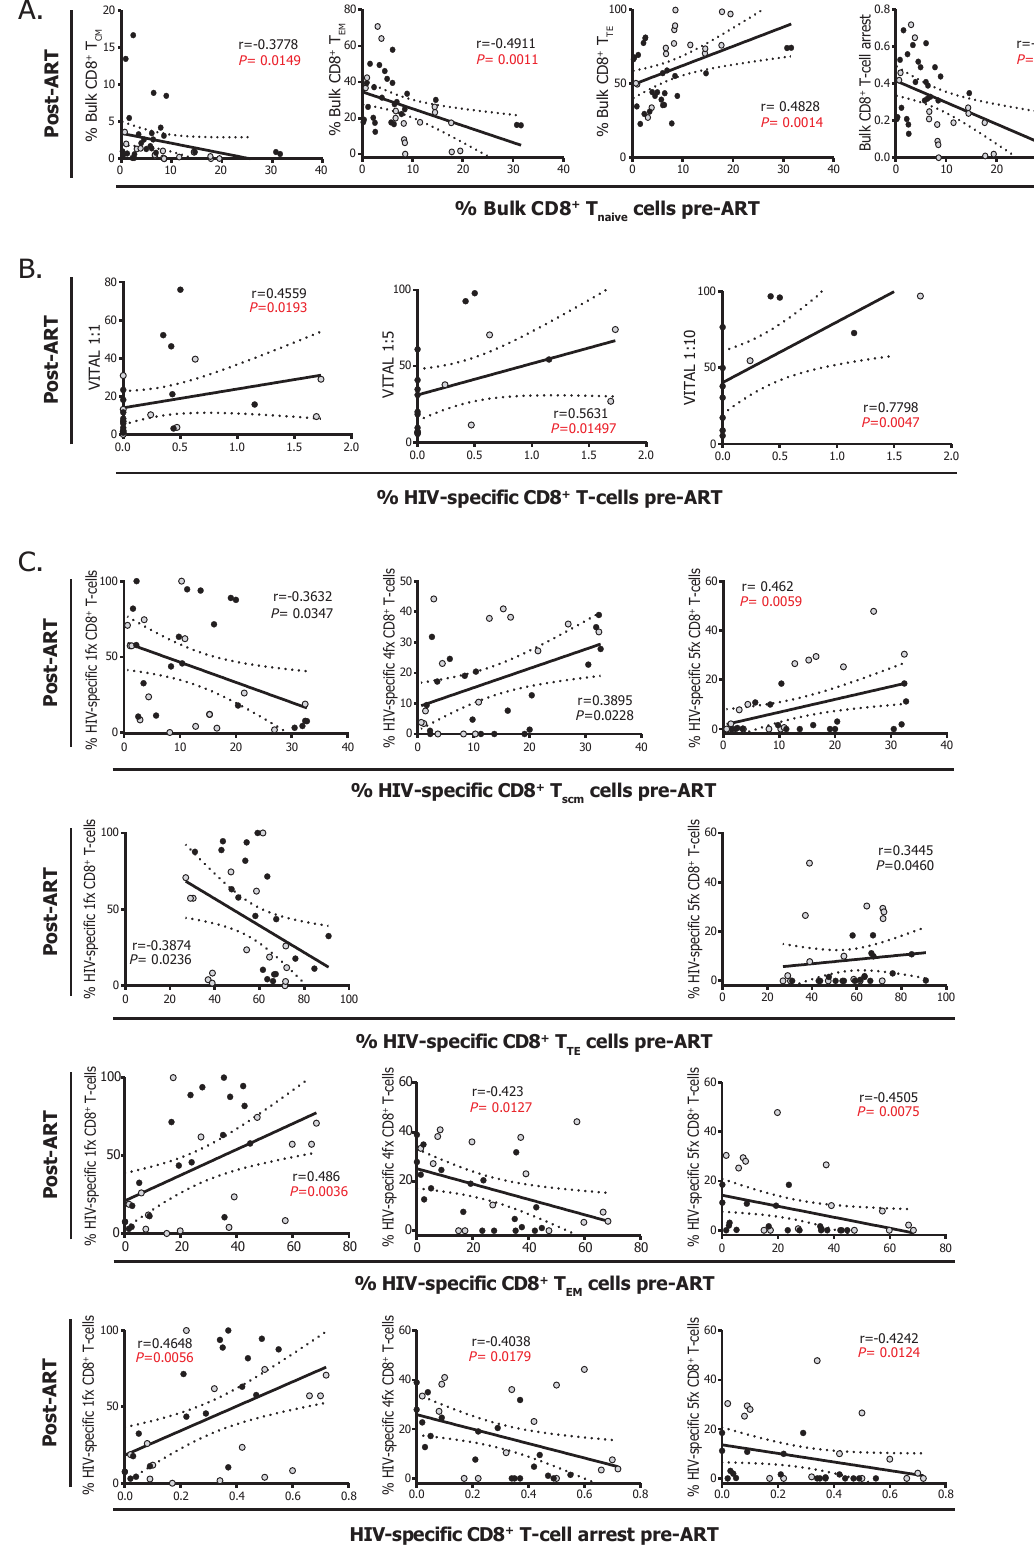
Figure 1: Correlation analysis between the phenotype and function of CD8+ T-cell response pre-